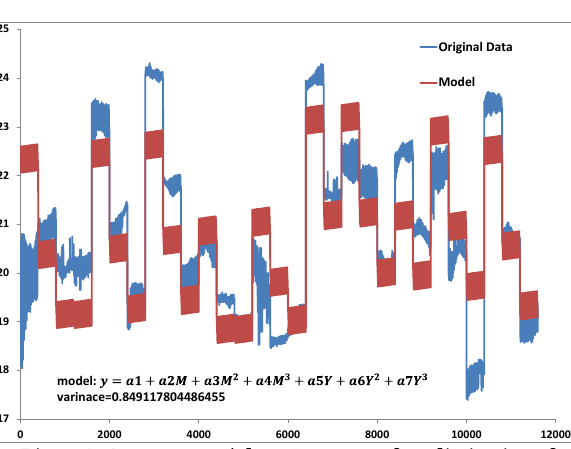
Table 6. Models form and their variance after elimination of blunders